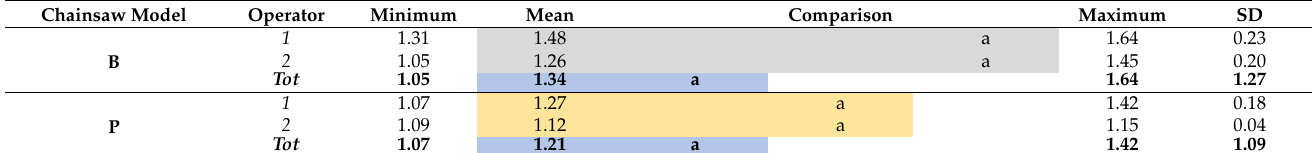
Table 5. Gross daily productivity (m 3 · h − 1 ), mean, maximum, minimum, and SD values for